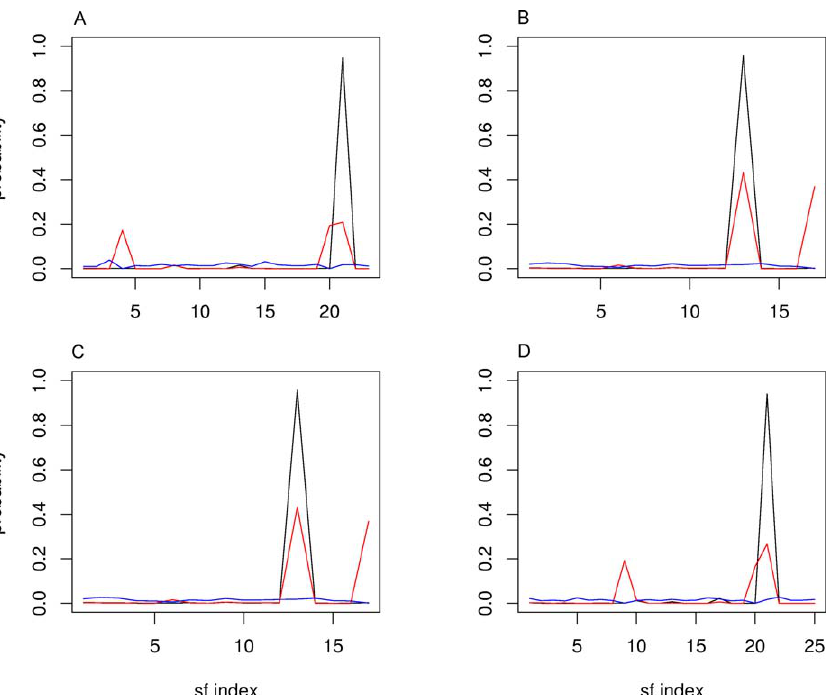
Figure 2. Integration of Structure Prediction with GO Annotations Red line represents the superfamily distribution for the predicted structures, P (SF j D); blue line, the superfamily distribution based on GO annotations, P (SF j GO). Black line represents the Bayesian combination ( P (SF j D,GO); Equation 2). Only superfamilies with a probability over 0.001 in either category are displayed. The names of the proteins and the GO annotations for which the black line is derived are (A) 1KMDA (Vam7p Px Domain)/Golgi to vacuole transport (process), (B) 1IOUA (v-SNARE)/vesicle fusion (process), (C) 1F32 ( Ascaris pepsin inhibitor-3)/endopeptidase inhibitor activity (function), and (D)